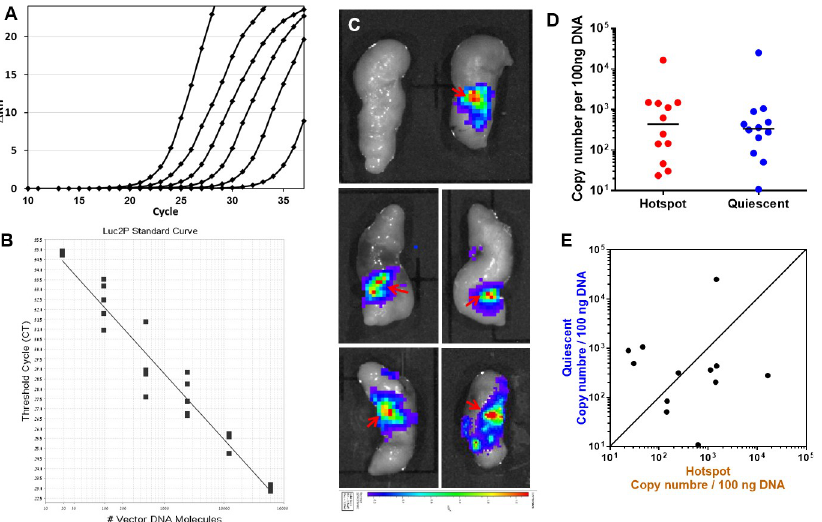
Fig 5. Foci of NF- κ B activity are not associated with high copy number of luminescence reporter. Real-time PCR was used for analyses of Luciferase gene copy number in human gut xenografts. Amplification of the NF κ B-Luciferase plasmid (A) and derived standard curve (B). The plasmid was serially diluted 1:5 starting from 6X10 4 vector DNA molecules and was amplified using the Luc2P primers. Plasmid DNA was diluted with genomic DNA to generate the standard curve (B) as described in Materials and methods. The amplification plot shows the change in fluorescence (Rn) as a function of the PCR cycle (A). Gut transplants were imaged ex-vivo for luminescence activity as described above (see Fig 2) to enable accurate sampling of hotspots (red arrows in C) and quiescent regions for extraction of genomic DNA from transduced and non-transduced transplants (top left panel in C) as negative controls. Copy number of reporter genes was not consistently higher in the luminescence foci compared with quiescent regions of NF- κ B activity in transduced transplants (D-E). Each data point represents sampled transplant in luminescence focus (red hotspots in D) or quiescent area (blue in D). Paring of hotspot and quiescent copy number in individual transplants is presented in